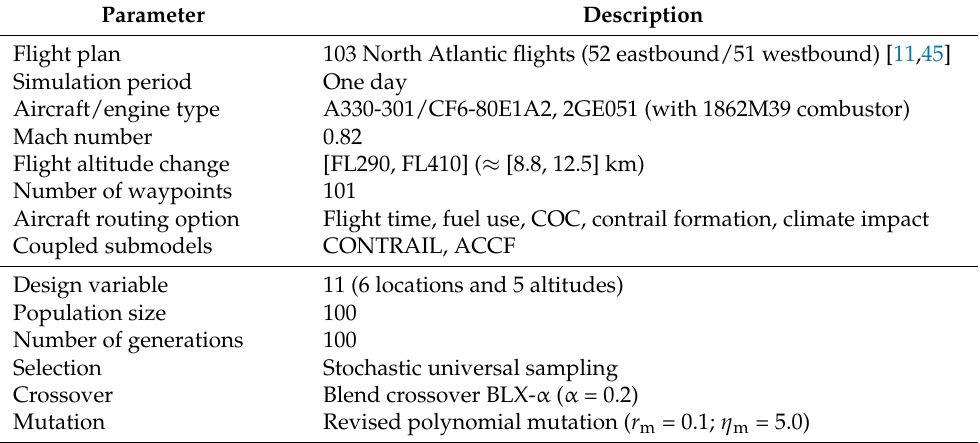
Table 2. Setup for the air traffic simulations by the AirTraf submodel. “FL290” stands for a flight level at 29,000 ft. The setup of the second group (divided by rows) is used for Adaptive Range Multi-Objective Genetic Algorithm (ARMOGA) [39–41]. In ARMOGA, the Blend crossover operator (BLX(Blend crossover)- α ; [43]) is employed with a user-specified crossover parameter α ; the revised polynomial mutation operator [44] is employed with a mutation rate r m and with an external parameter controlling the shape of the probability distribution η m . Details of these parameters are described by Yamashita et al.